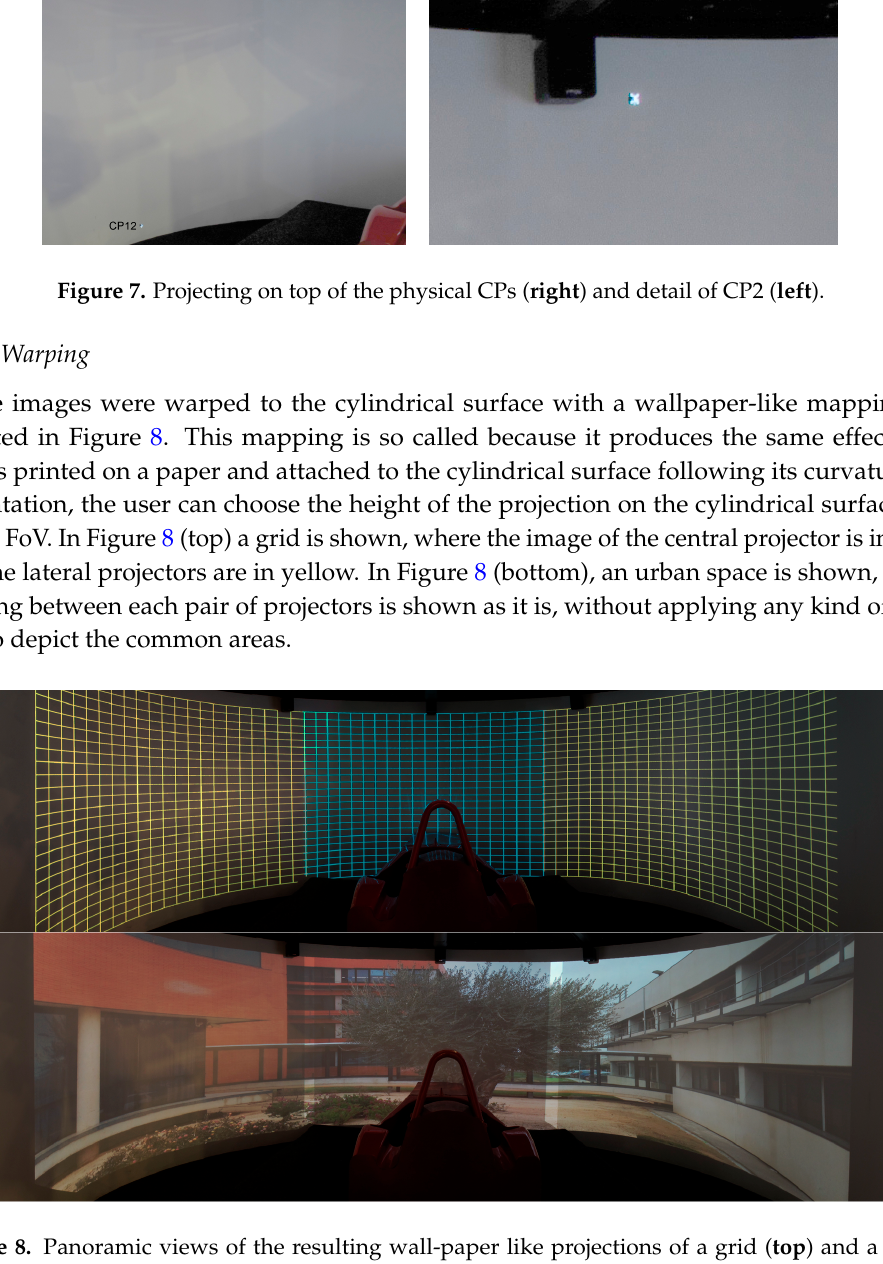
Figure 6. Residuals (×50) of the three projector calibration, where: ( a ) Proj1; ( b ) Proj2; ( c ) Proj3.